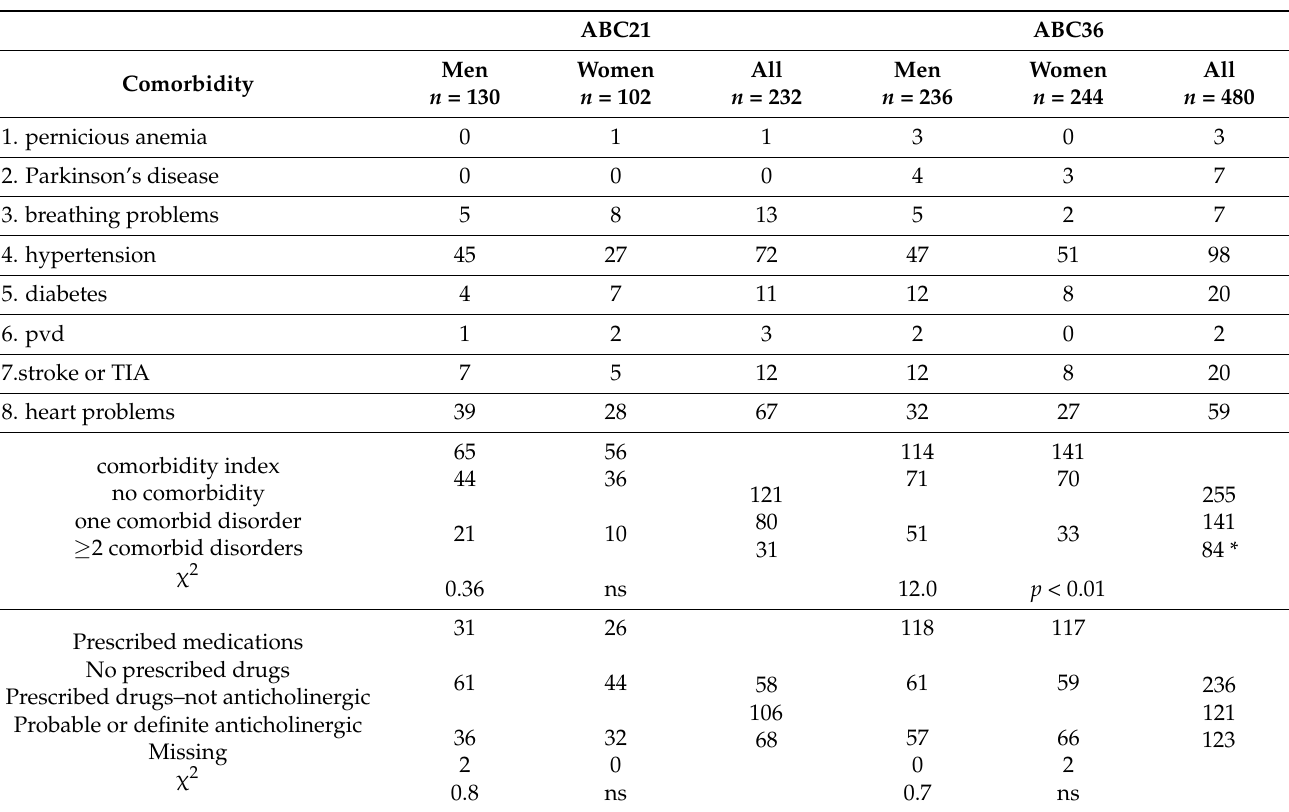
Abbreviations (Table 2): pvd–peripheral vascular disease; TIA–Transient Ischemic Attack. Statistical tests: comorbidity index and use of prescribed drug distributions tested using χ 2 do not differ significantly between sexes or between cohorts, but the frequency of major comorbidities was greater in ABC36 than ABC21 (* χ 2 = 9.1, p <